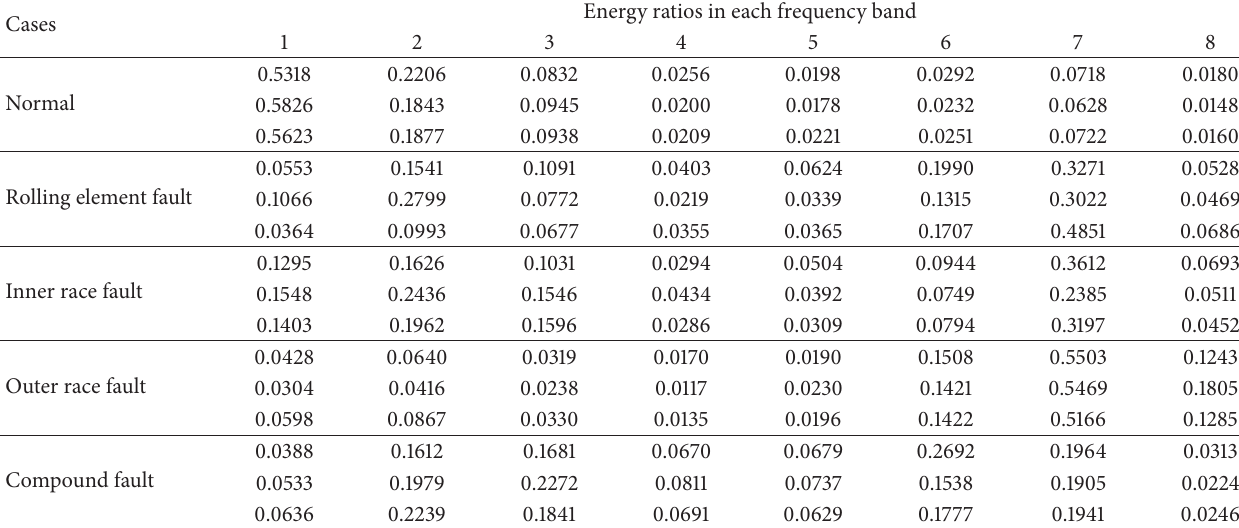
Table 2: Bearing test